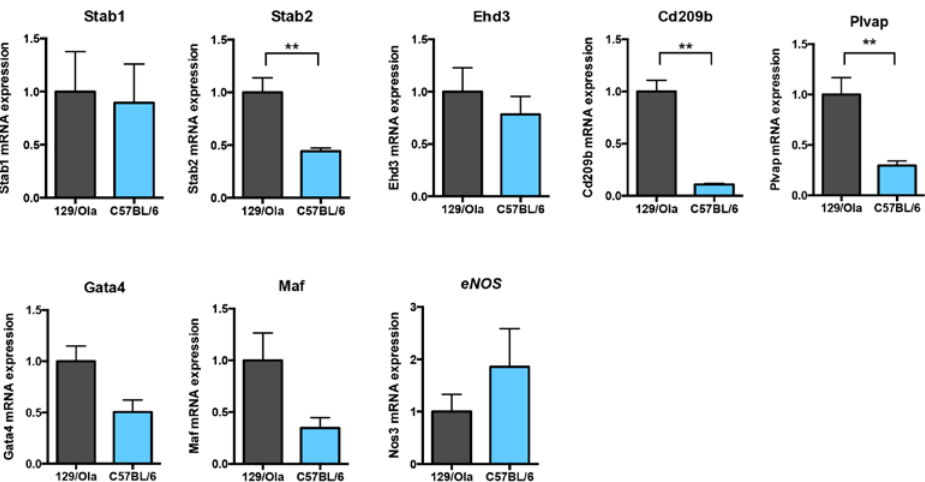
Figure 4. mRNA levels of LSEC di ff erentiation markers in the WT mice of 129 / Ola and C57BL / 6 genetic backgrounds. mRNA expression levels of the LSEC markers were analyzed by RT-qPCR from freshly prepared LSEC from six 129 / Ola and four C57BL / 6 WT mice. Values were normalized to Rpl13a